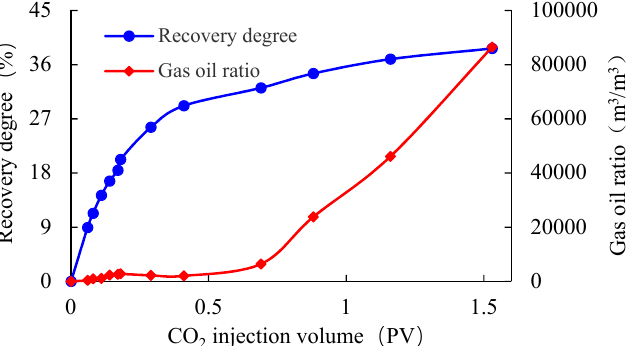
Figure 16. The relationship between CO 2 injected volume and recovery degree, gas oil ratio (Scheme 3).